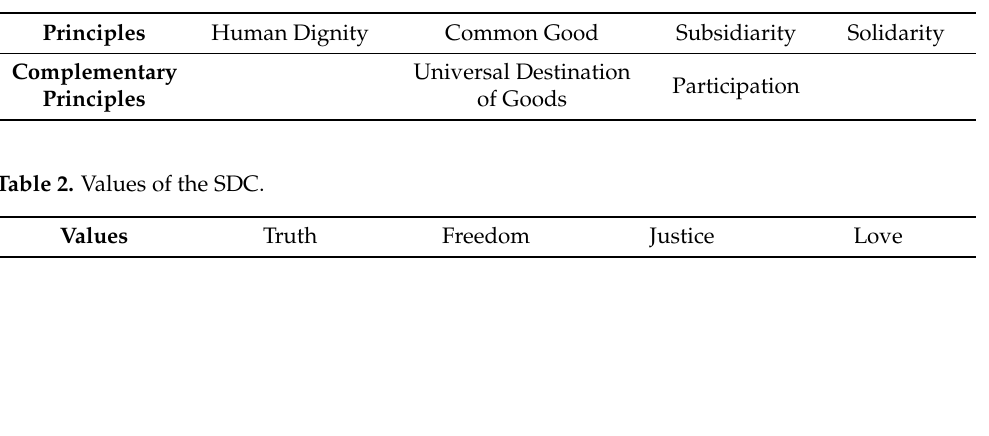
Table 1. Principles of the SDC.